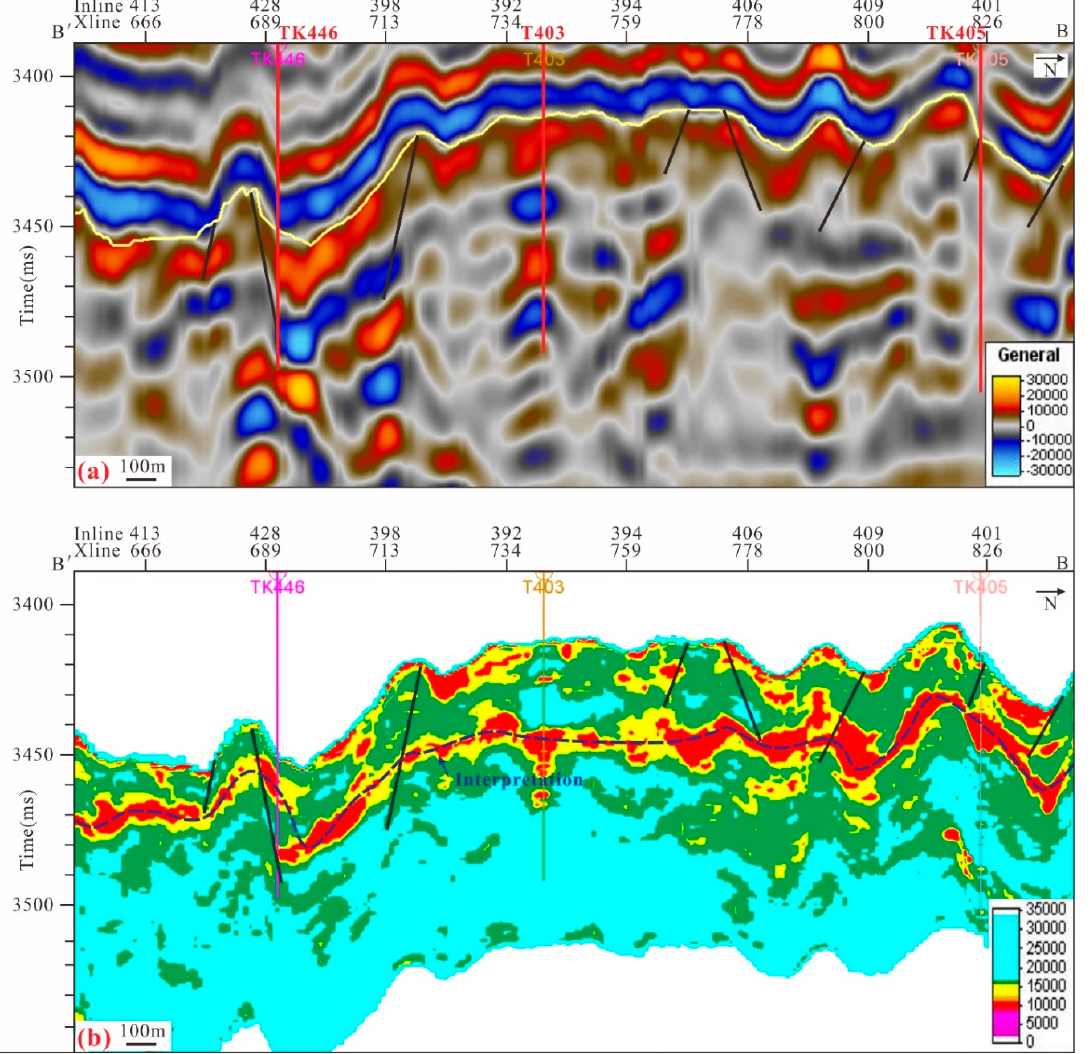
Figure 6. Different seismic profiles crossing wells TK405 ‐ T403 ‐ TK446; see profile location B ‐ B’ in Figure 6. Di ff erent seismic profiles crossing wells TK405-T403-TK446; see profile location B-B (cid:48) in Figure 1d. ( a ) Amplitude seismic profile, ( b ) acoustic impedance inversion profile. Figure 1d. ( a ) Amplitude seismic profile, ( b ) acoustic impedance inversion